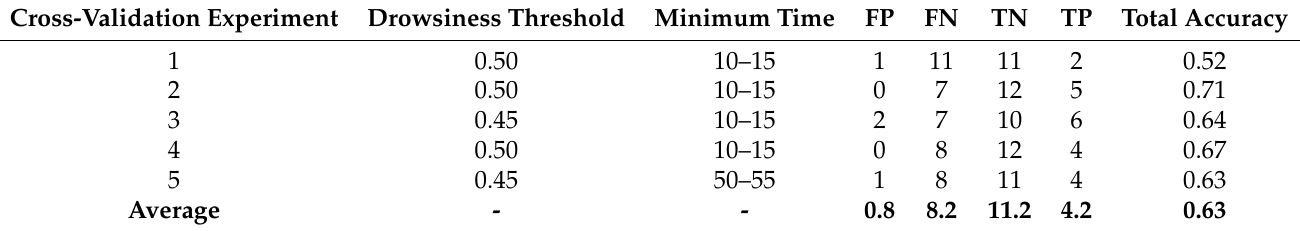
Table 10. Cross validation of the results obtained by Alternative II over test